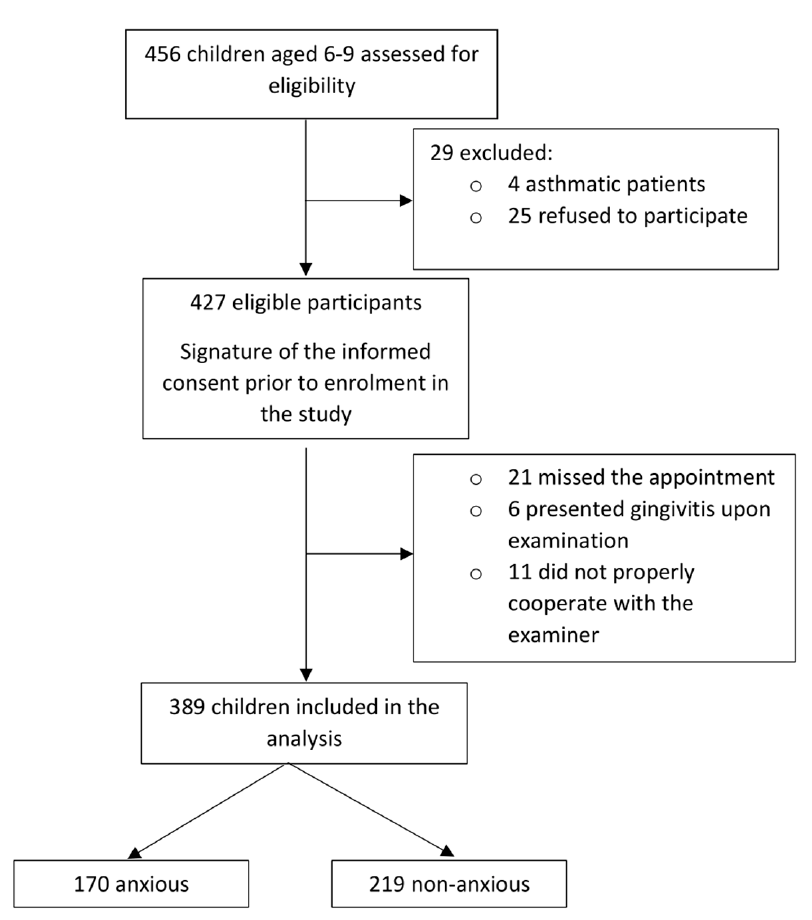
Figure 1. Flow diagram showing patients selection for the study.